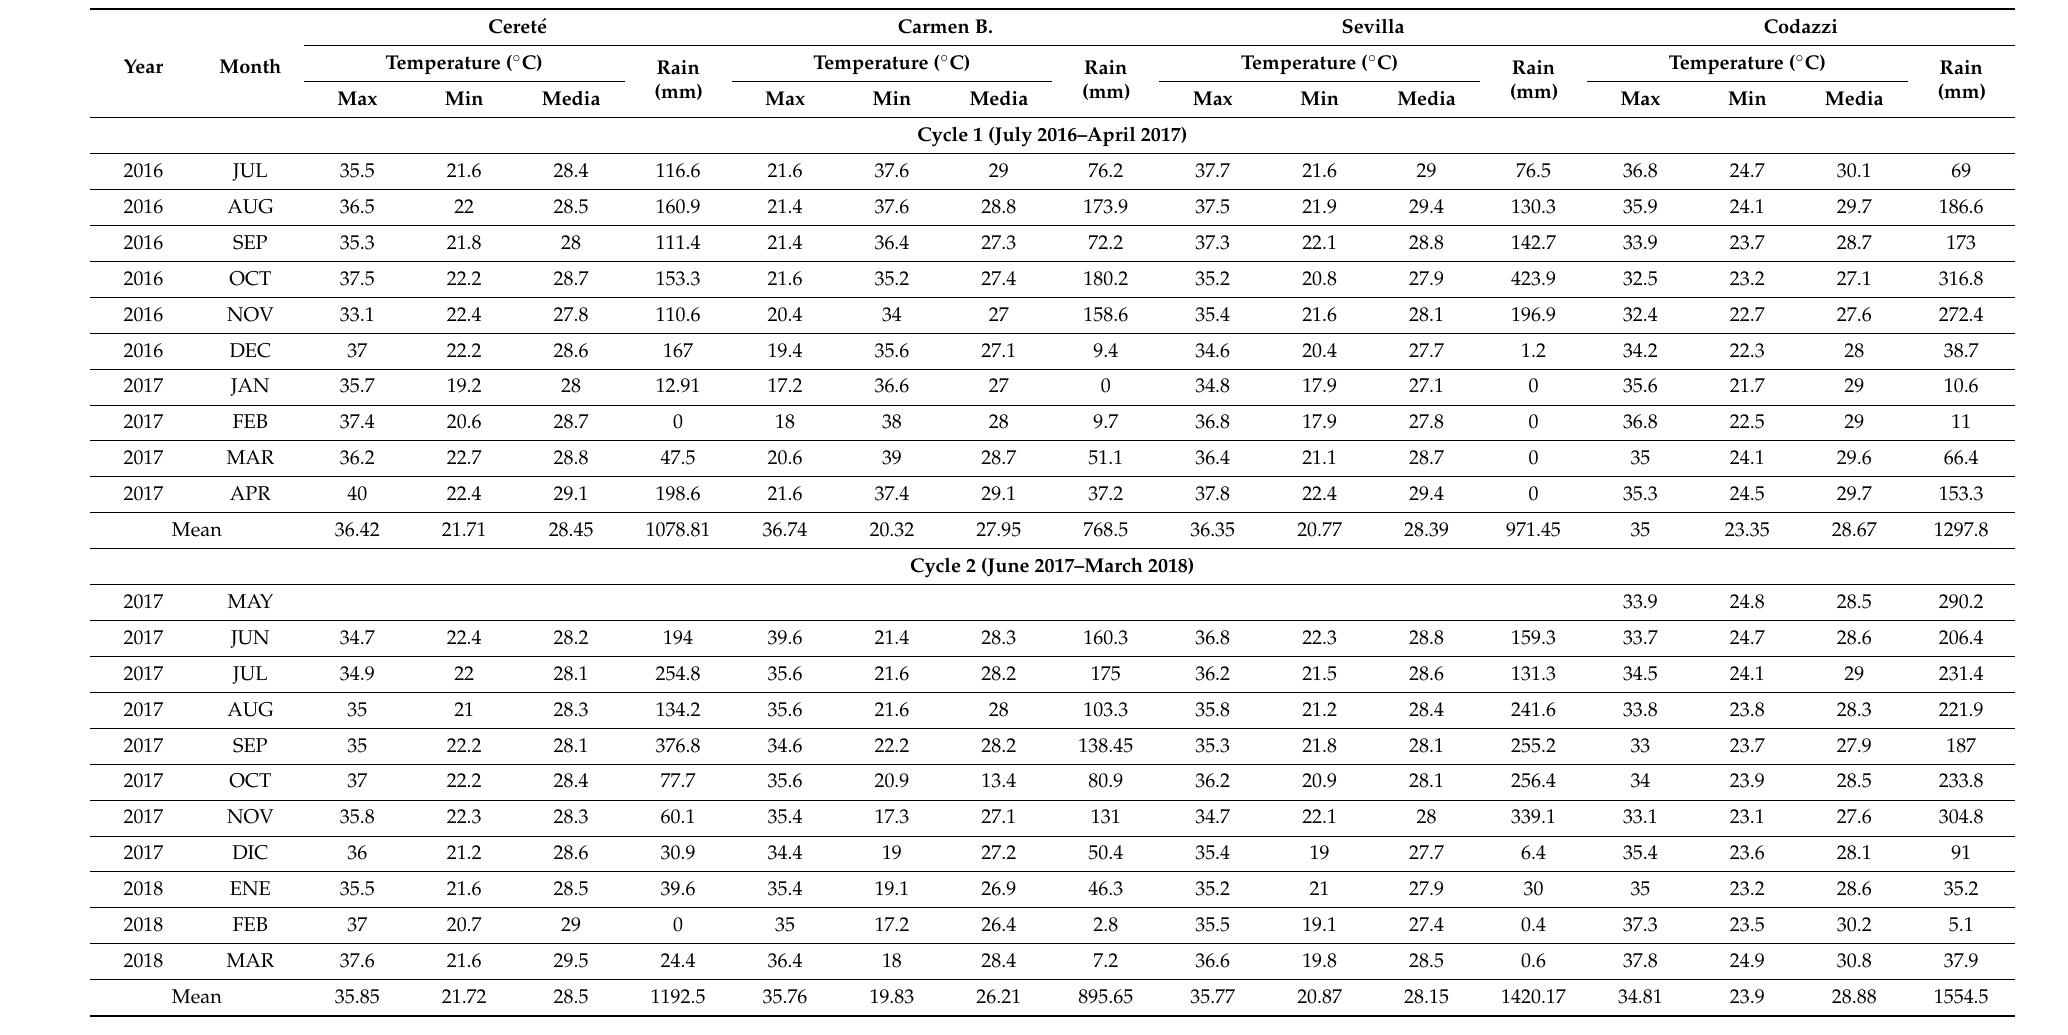
Table 2. Climatic conditions during evaluation period in four locations in the Caribbean Coast region of